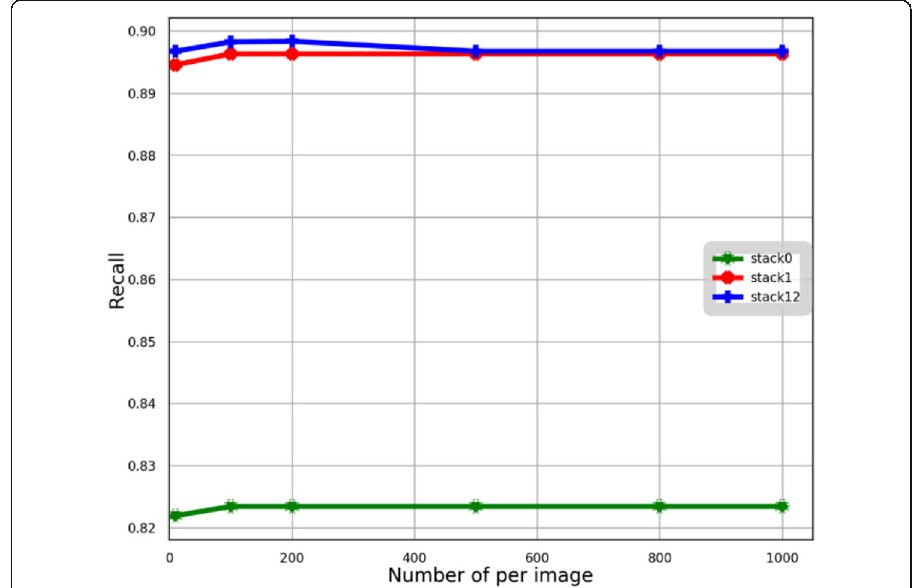
Fig. 8 Diagram the effect of the recommended number on the